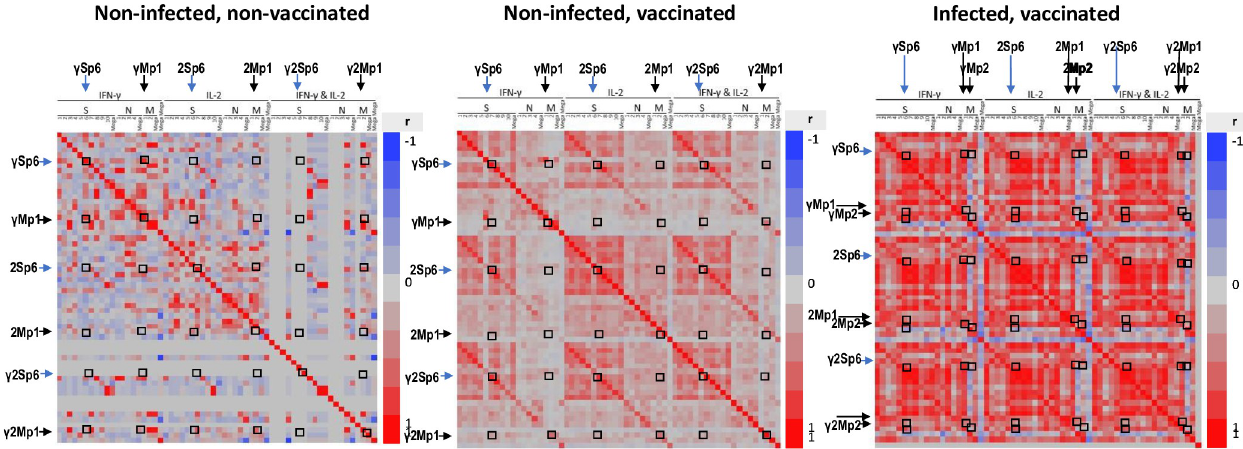
Fig 6. Heat map profiles of all IFN- γ , IL2, and IFN- γ +IL2 responses to each S, N, and M peptide subpool. Group 1 = uninfected, unvaccinated; Group 2: uninfected, vaccinated; Group 3: infected, vaccinated. All IFN- γ ( γ ), IL2 (2), and IFN- γ +IL2 ( γ 2) responses of individual subjects with each S, N and M peptide subpool were compared with each other using the Pearson correlation coefficient (r), a value of “1” is shown in bright red and represents 100% positive correlation, and a value of -1 in bright blue represents 100% negative correlation. Intersection of each parameter is boxed. Sp6 and Mp1: γ Sp6 and γ Mp1, 2Sp6 and 2Mp1, and γ 2Sp6 and γ 2Mp1, were mapped on Groups 1, 2, and 3. Sp6 and Mp2: γ Sp6 and γ Mp2, 2Sp6 and 2Mp2, and γ 2Sp6 and γ 2Mp2, were mapped on Group